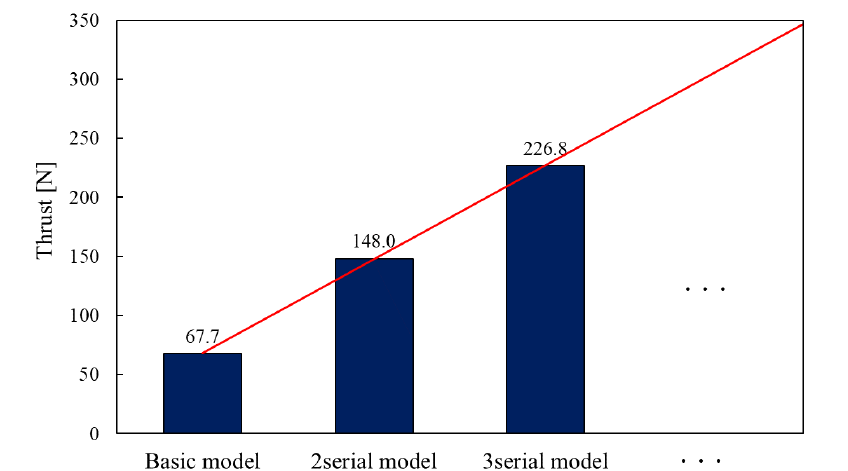
Figure 13. Thrust waveform of serial type.